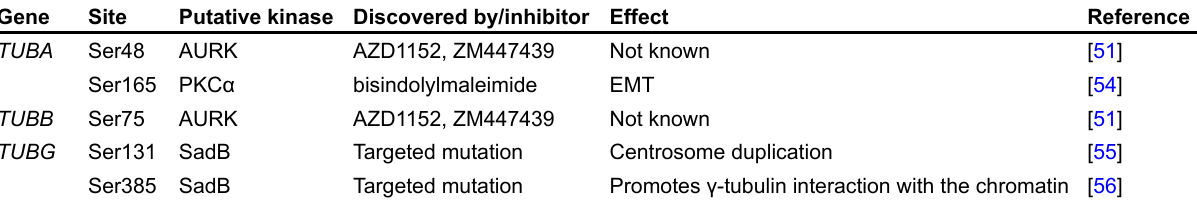
SadB: synapses of amphids defective